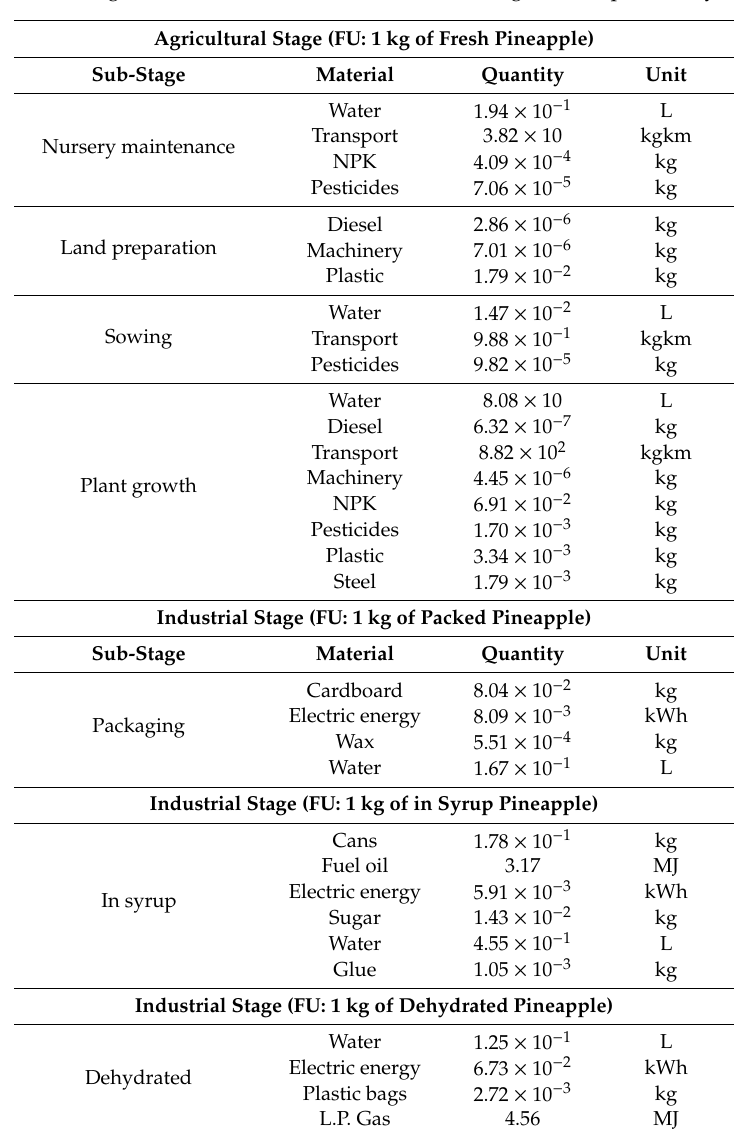
Table 5. Foreground data collection from the main stages of the product